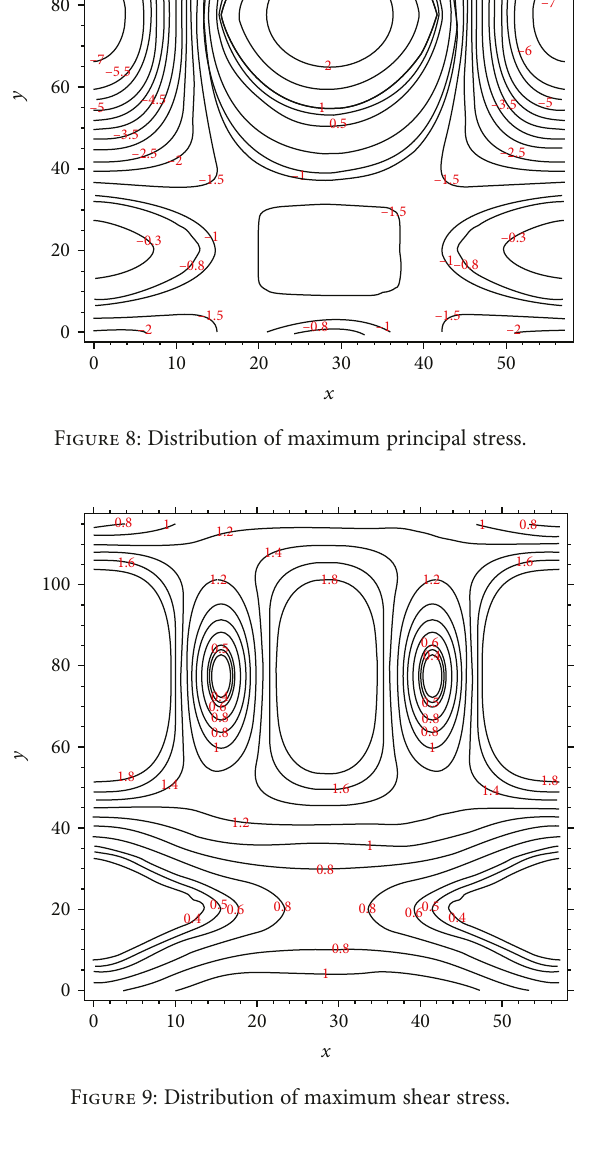
Figure 13: Distribution of support pressure along the dip